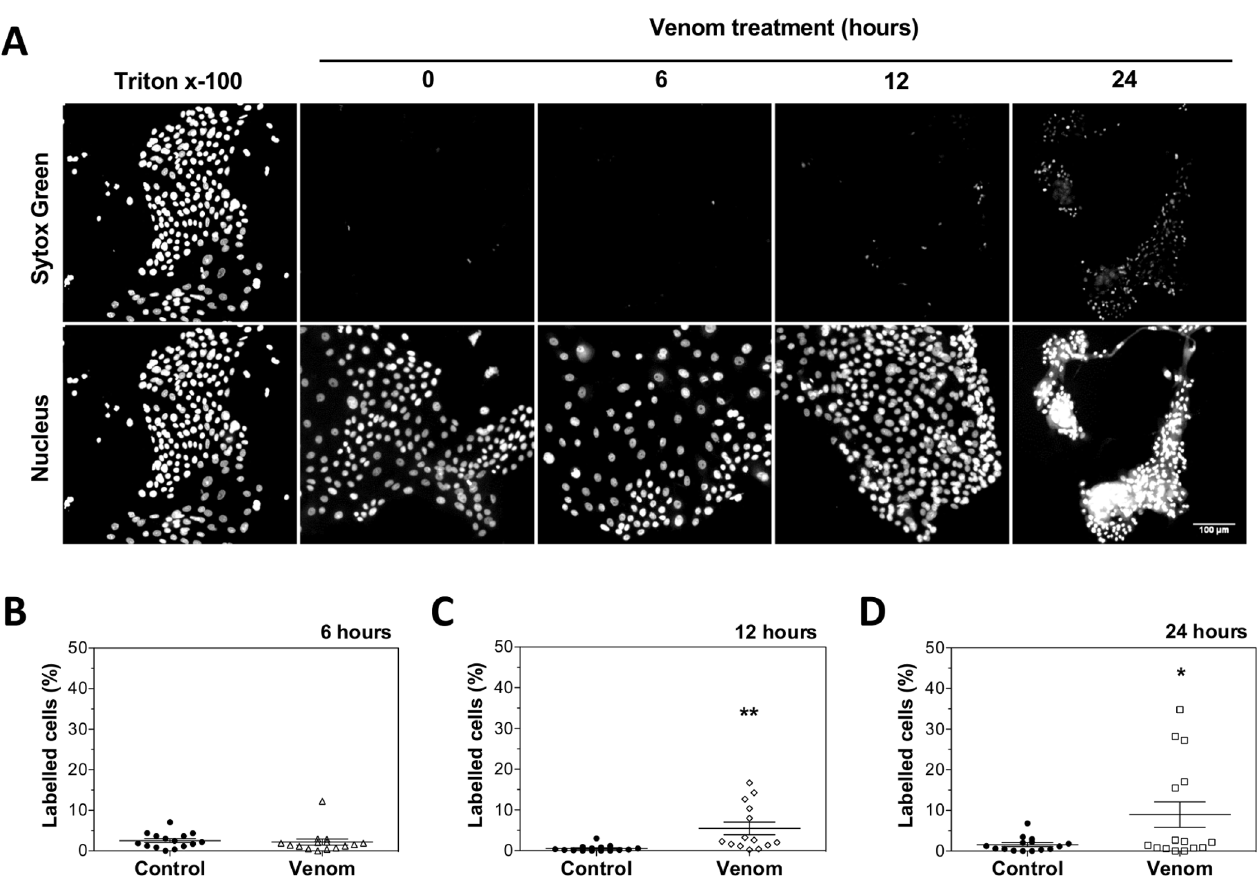
Fig 5. Necrosis induced by L . m . muta venom in keratinocytes. (A) Representative images of keratinocytes treated with 0.1% Triton X-100 for 30 minutes, 2x EC 50 of L . m . muta venom for 6, 12 and 24 hours, or left untreated. Cells were stained with Sytox Green and DAPI to evaluate necrotic and normal cells, respectively. Scale bar = 100 μ m. Graphs showing the percentages of stained nucleus after treatment during 6 hours (B) , 12 hours (C) and 24 hours (D) . Data are represented as means ± SEM (n = 3, data were collected from three independent experiments). Venom-treated group was compared to control using Student’s t test ( (cid:3)(cid:3) p < 0.05, (cid:3) p <